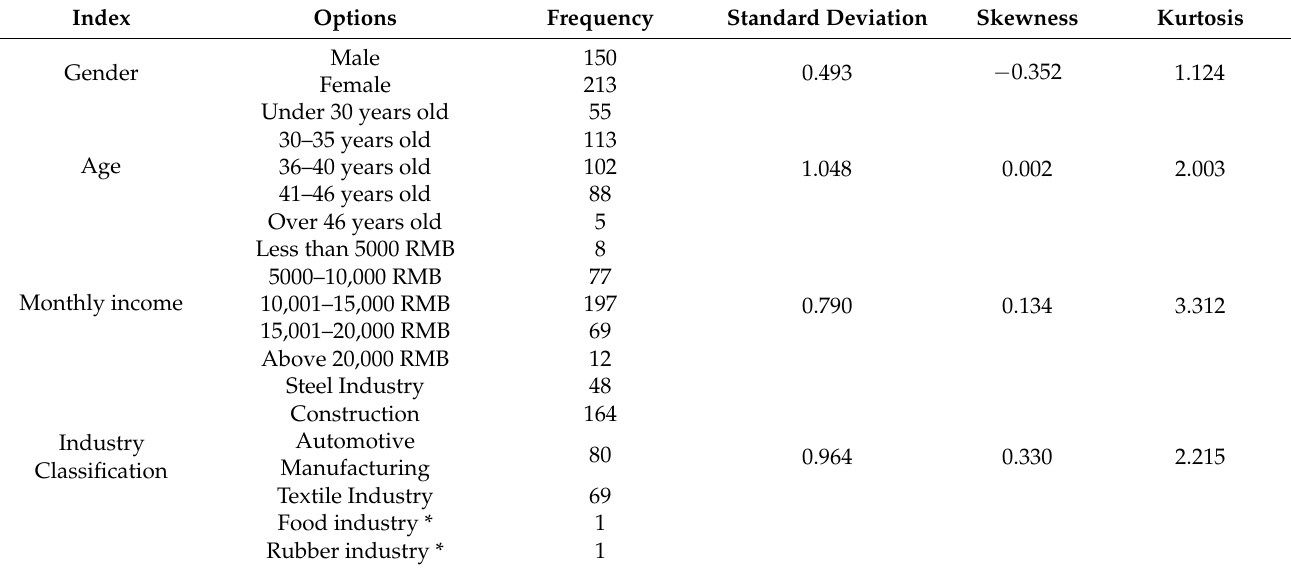
Table 2. Demographic characteristics of the